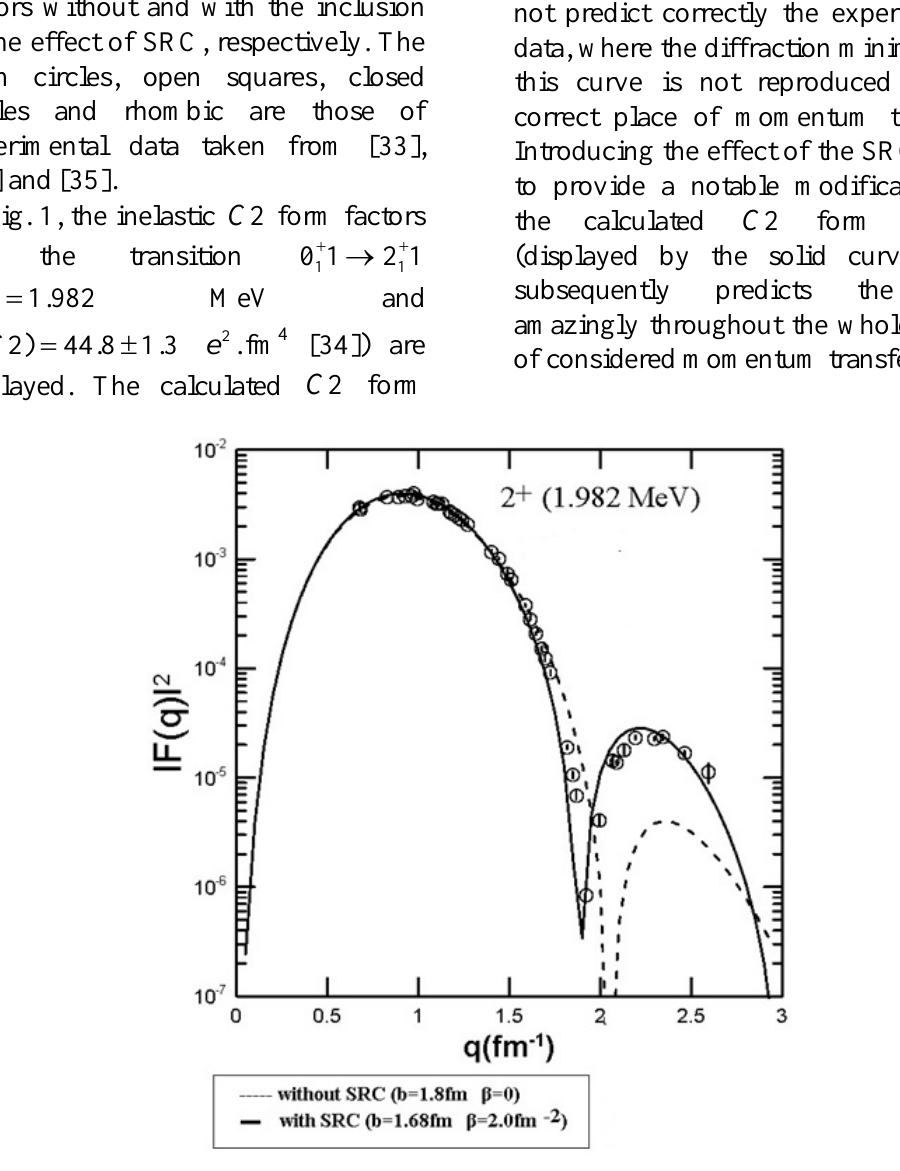
Fig. 1: Inelastic Coulomb 2 C form factors for the transition to the 12 + (1.982 MeV) state. The dashed and solid curves are the calculated 2 C form factors without and with the inclusion of the effect of the SRC, respectively. The open circle symbols are those of the experimental data taken from